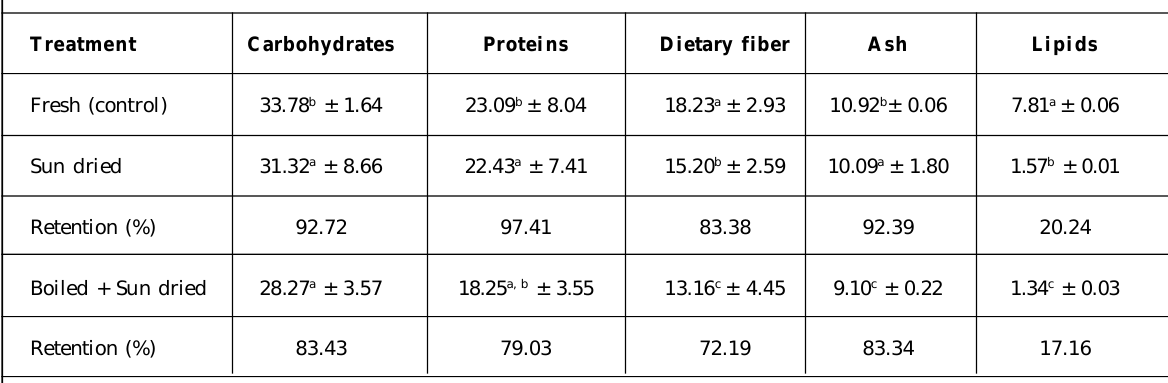
Table 1: Retention of proximate contents of fresh and processed cowpea leaves (dry basis) (g/100 g) Treatment